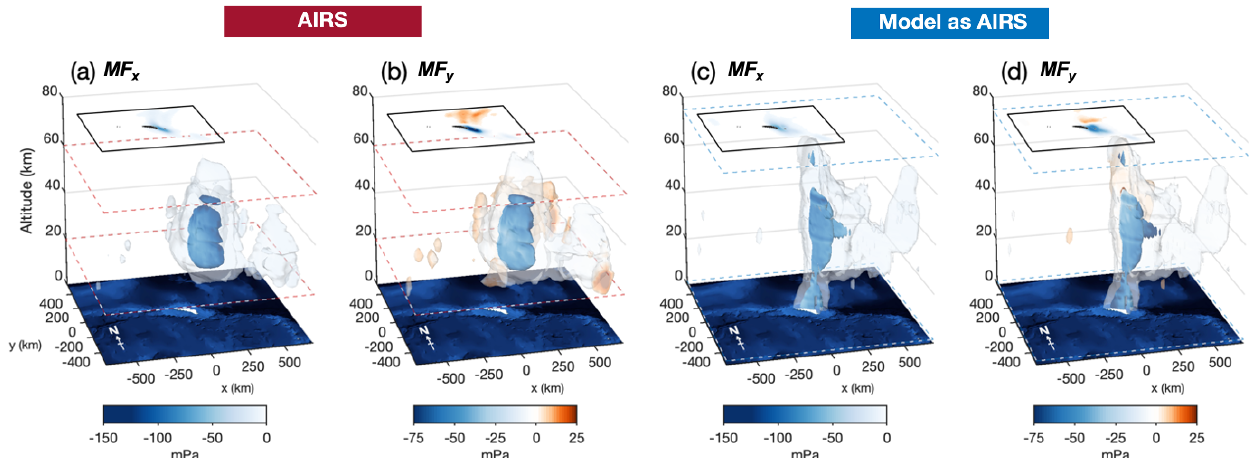
Figure 7. Same as Fig. 6 but for the zonal and meridional components of gravity wave momentum flux MF x and MF y for the AIRS and model-sampled-as-AIRS data at 17:00UTC on 5 June 2015. In this example, westward propagation has been assumed based on sequential model results, indicating quasi-stationary mountain wave phase fronts with time subject to eastward wind conditions. This allows us to constrain the directional ambiguity in the zonal and meridional